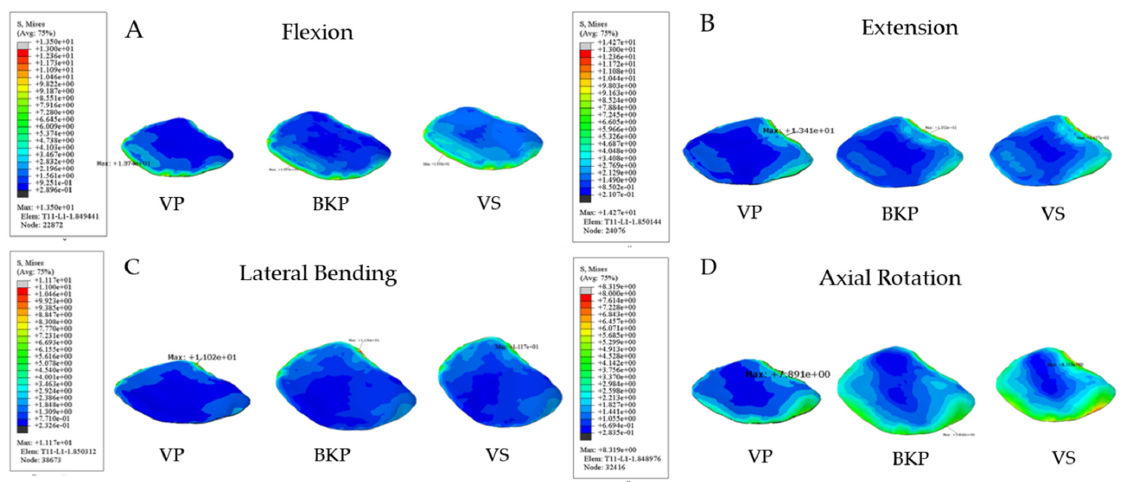
Figure 6. Finite element stress nephogram of interfacial stress at upper L1 endplate. ( A ): Flexion. ( B ): Extension. ( C ): Lateral bending. ( D ): Axial rotation.